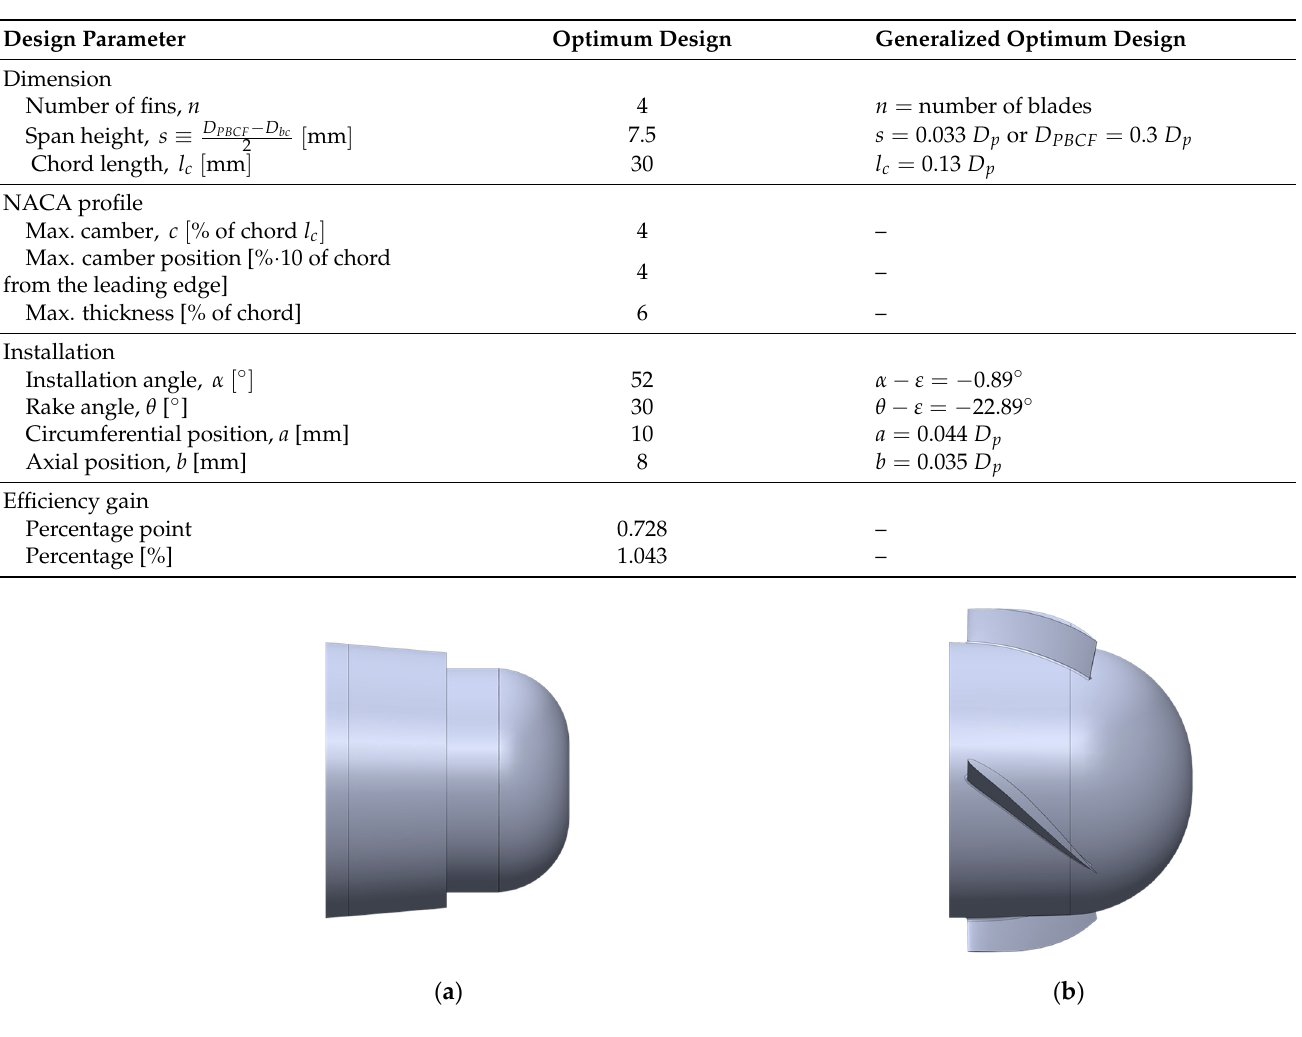
Figure 8. The original boss cap vs. the new boss cap with optimized fins. ( a ) Original boss cap. ( b ) New boss cap, with optimized PBCFs.